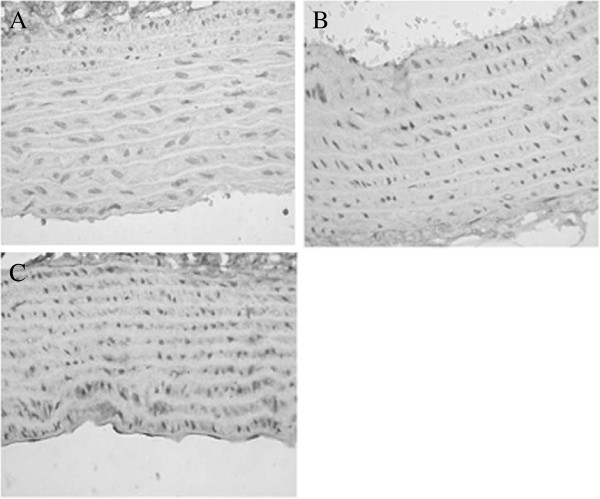
Collagen I staining of the vascular wall in groups A, B, and C. (A,B) A small amount of collagen I deposition was seen in the vascular wall of group A (×400). (C) Collagen I component was significantly increased in group C (×400).